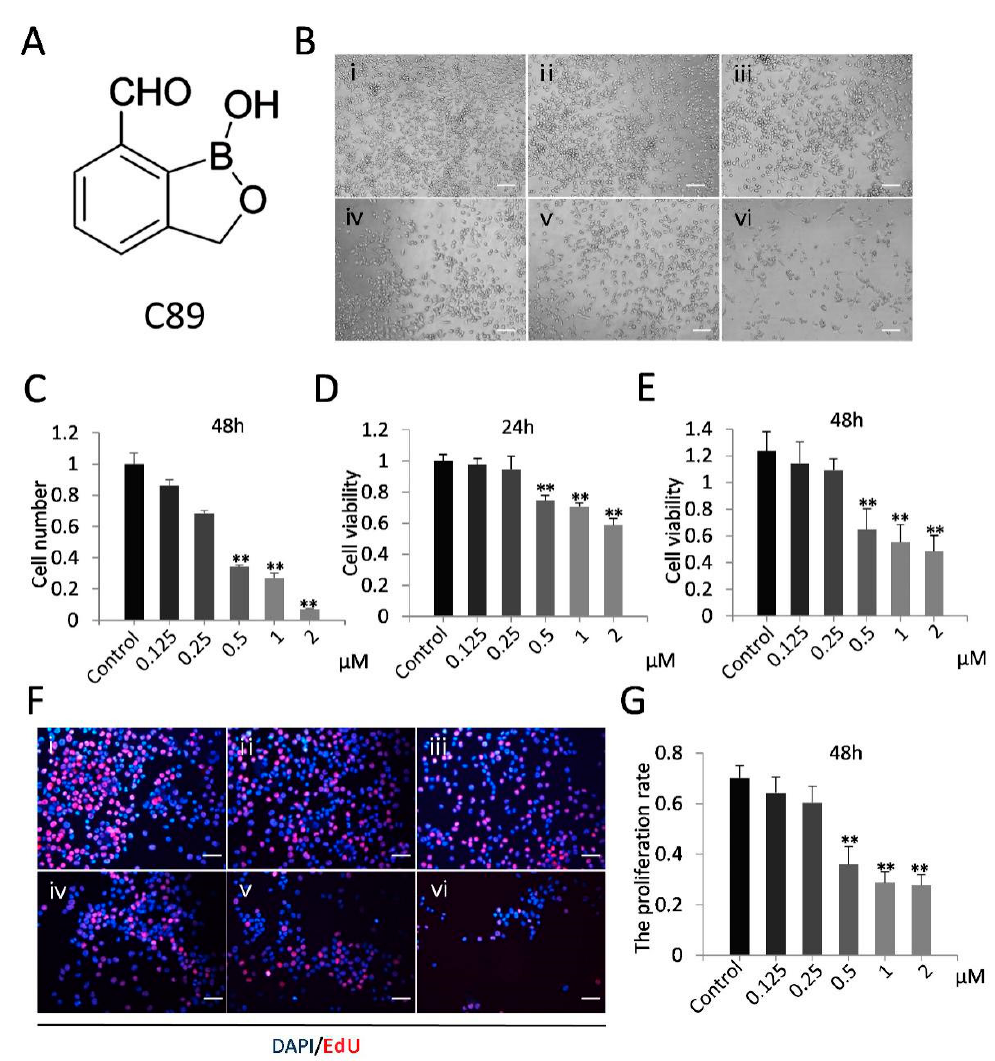
Figure 1. E ff ect of compound 89 (C89) on female germline stem cell (FGSCs) in vitro. ( A ) Structure Figure 1. Effect of compound 89 (C89) on female germline stem cell (FGSCs) in vitro. ( A )